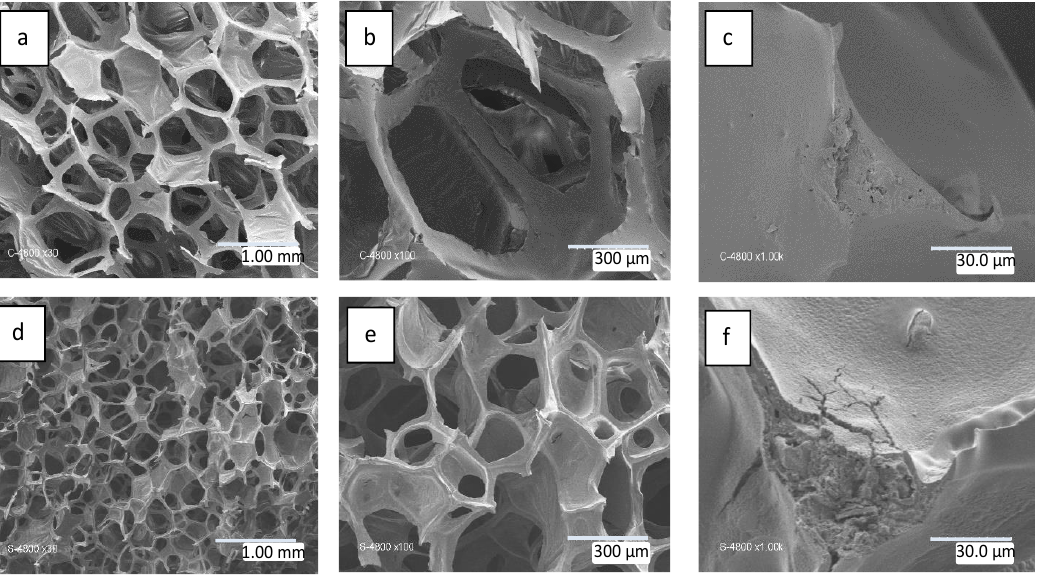
Figure 2. SEM images for ( a – c ) polyurethane foam and ( d – f ) SiC foam pyrolyzed at 1200 °C-2 h in Ar.